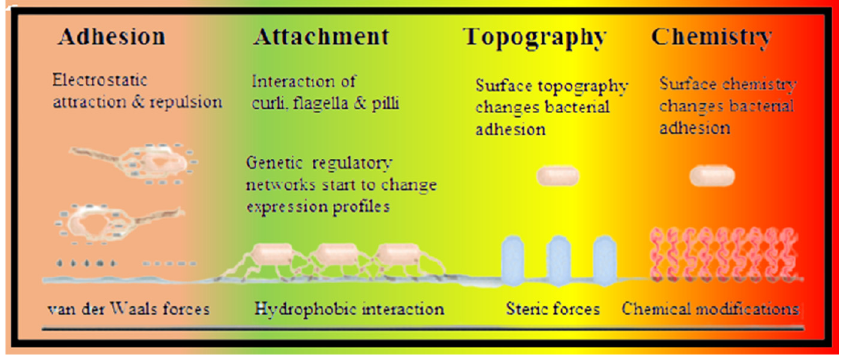
Figure 7. Interaction between surface and bacterial cells [28] . Adapted with permission from ref.